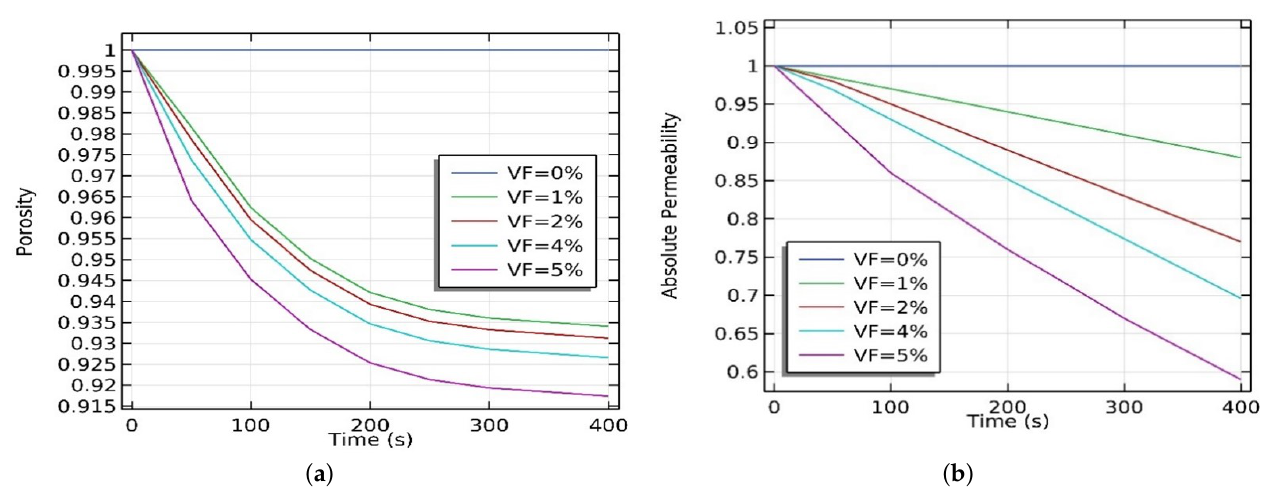
Figure 17. ( a ) The influence of nanoparticle VFs on porosity and ( b ) permeability. 3.10. The Effect of Ideal NP SiO 2 on ORF at Different Inlet Fluid Temperatures and Volume